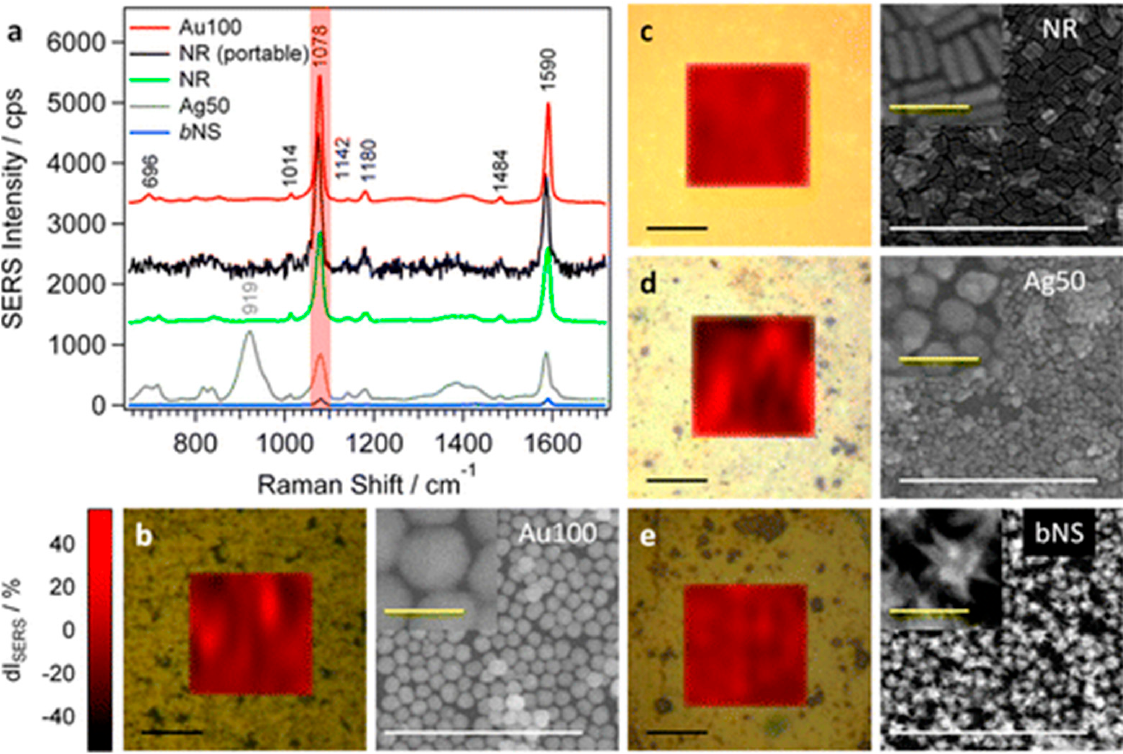
Figure 2. ( a ) Averaged SERS spectra of 4-mercaptobenzoic acid (10 μ M) spherical nanoparticles (100 ± 10 nm) ( b ), gold nanorods (61 ± 5 nm length; 15 ± 2 nm width) ( c ), silver nanoparticles (51 ± 8 nm) ( d ), and big gold nanostars (56 ± 4 nm/98 ± 7 nm) ( e ). The corresponding SERS maps for the signal at 1078 cm − 1 (red-shaded area in ( a ) as a function of the deviation from the average intensity dI (in %), together with representative SEM images of the assemblies before analyte incubation. The black SERS spectrum in ( a ) corresponds to the average of three 4-MBA spectra on the Au-NR sample measured with a portable Raman spectrometer. Reproduced with permission from [29], Langmuir; published by the American Chemical Society, 2015. Further permissions related to this material ex- cerpted should be directed to the American Chemical Society.